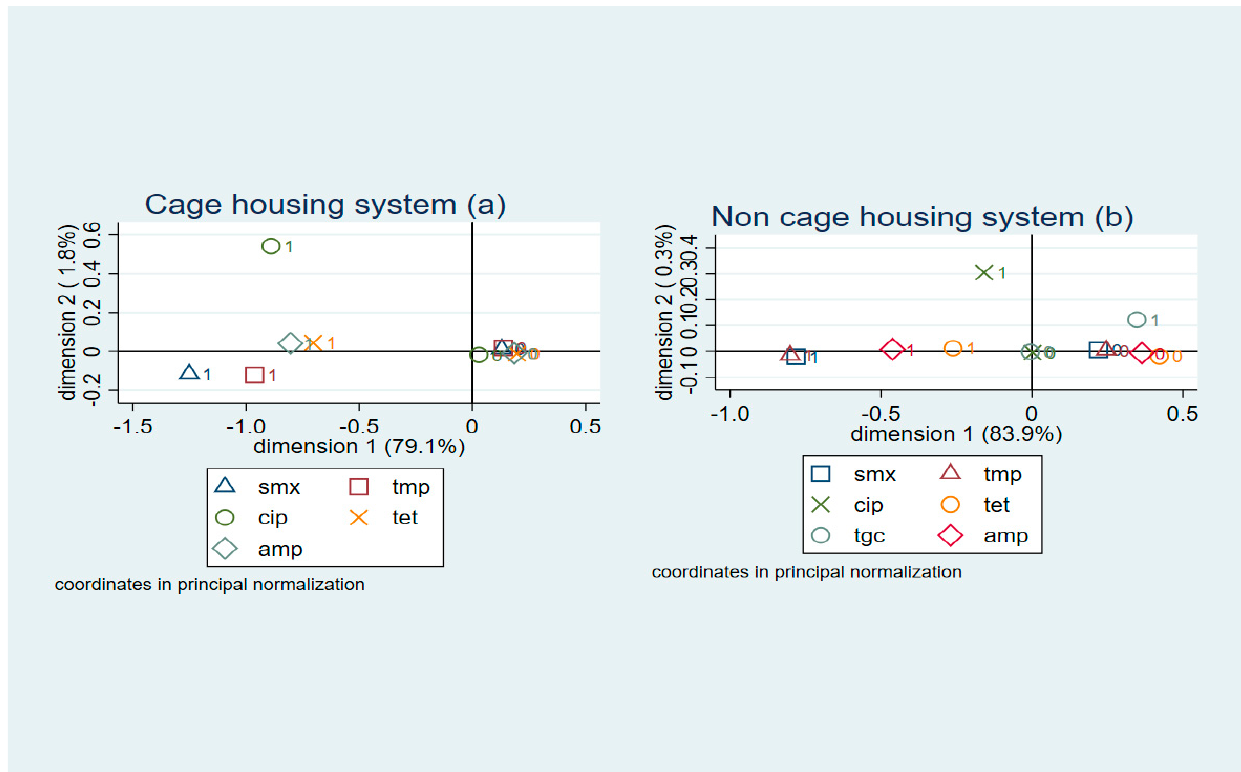
Figure 3. Multiple correspondence analysis coordinate plot displaying the presence (1) and absence (0) of resistance to six antimicrobials in E. coli isolates ( n = 100) from ( a ) cage and ( b ) non-cage retail table eggs for the first two dimensions. SMX: sulfamethoxazole; TMP: trimethoprim; CIP: ciprofloxacin; TET: tetracycline; TGC: tigecycline; AMP: ampicillin.